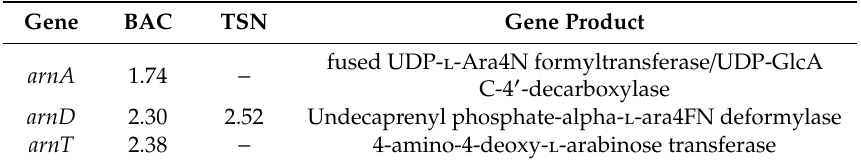
Table 4. Increased transcription of genes from the arnBCADTEF operon in response to three biocides. BAC—benzalkonium chloride, TSN—triclosan.